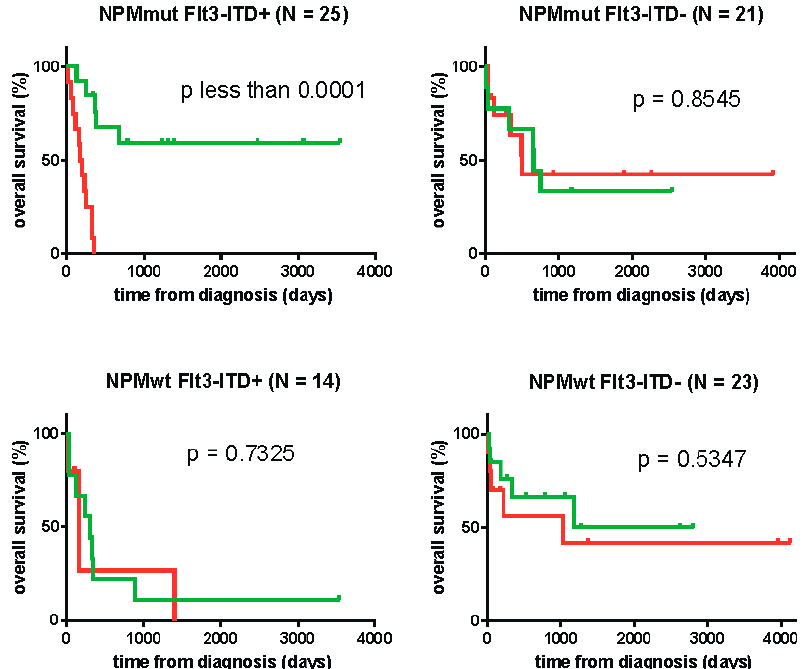
Figure 4. Survival curves for AML patient groups according to PD-L1 levels. AML patients were divided in four subcohorts with di ff erent combinations of FLT3 and NPM1 mutational status. Each subcohort was subdivided according to v1 / v2 PD-L1 cDNA and the corresponding survival curves were compared using the Mantel–Cox t -test. The reached p-values are given in the